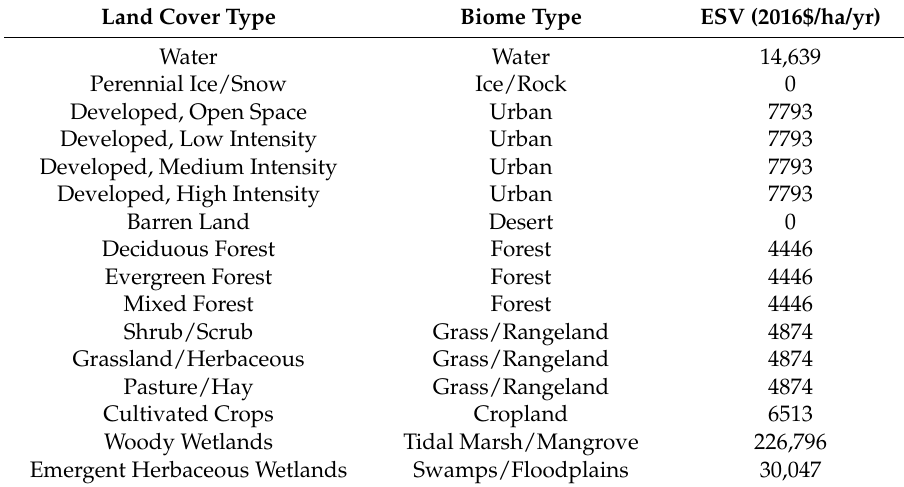
Table A2. Land cover reclassification scheme and corresponding